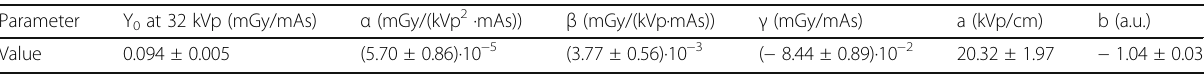
Table 2 Values of the coefficients of Eq. (2), (3), and (5) evaluated for the reference Hologic Selenia Dimensions (device A) Parameter